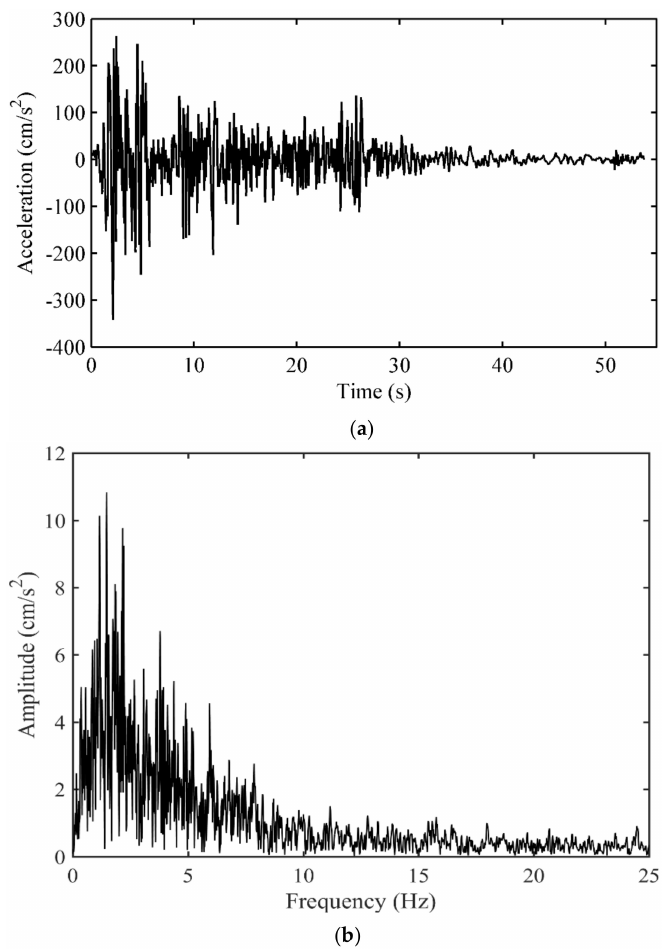
Figure 7. Recorded acceleration of El Centro earthquake: ( a ) Acceleration time history; ( b ) Amplitude